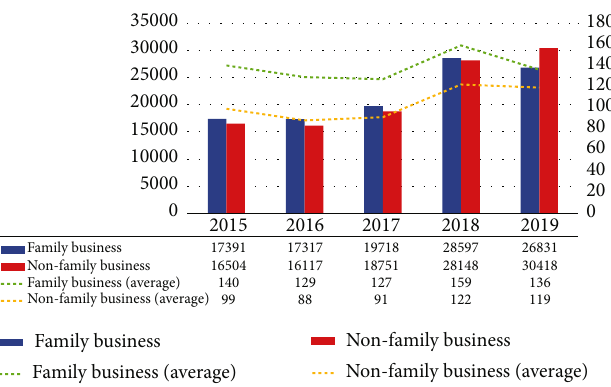
Figure 5: The speci fi c proportion of family enterprises with a shareholding ratio of more than